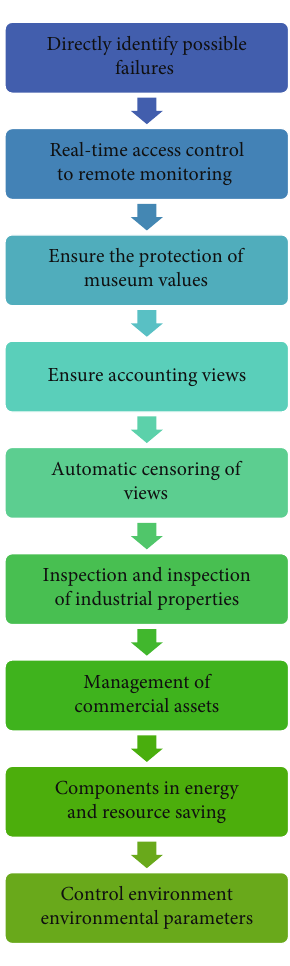
Figure 1: Objectives of low-cost wireless sensor control